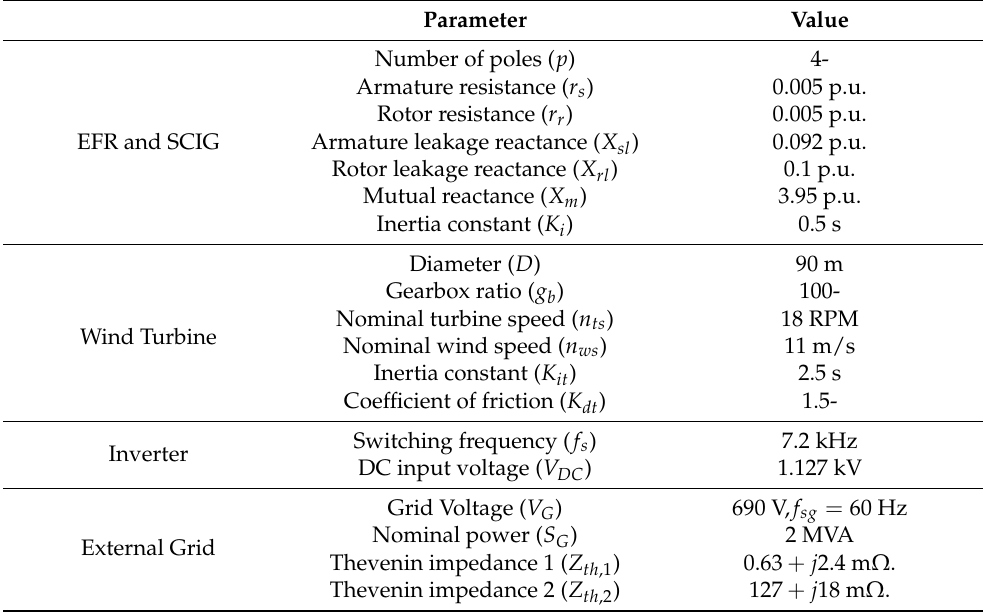
Table 1. EFR, SCIG, and system